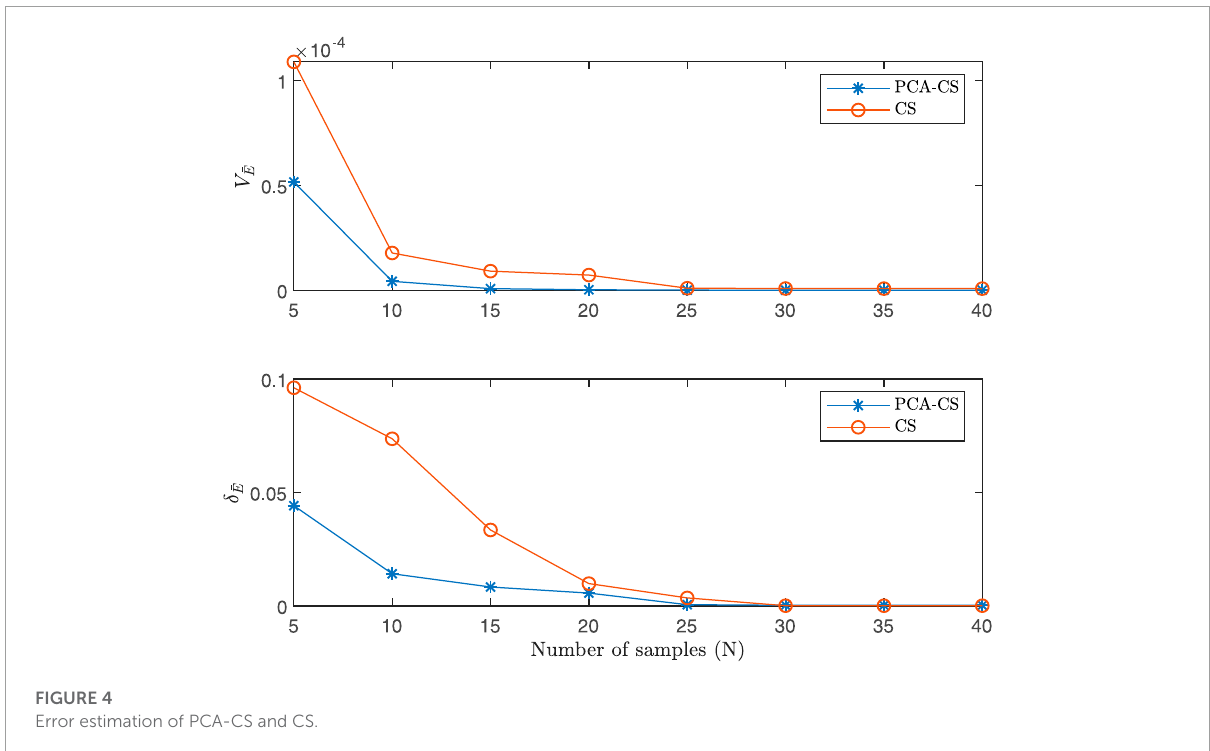
FIGURE 4 Error estimation of PCA-CS and CS.